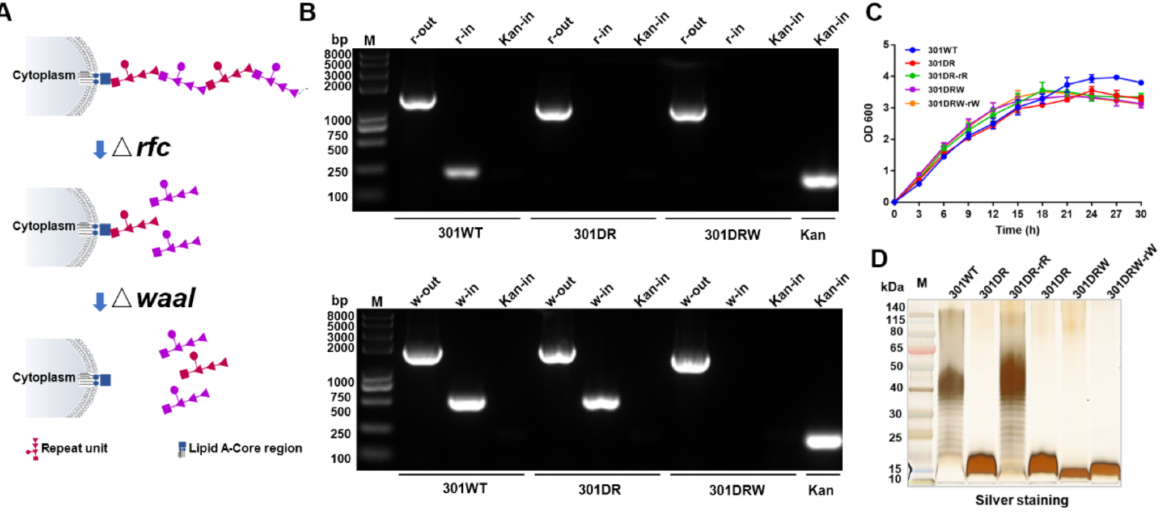
Figure 1. Establishment of rfc and waaI deletion mutants. ( A ) Schematic diagram of the effect of gene knockout on polysaccharides. rfc is an O-antigen polymerase and the knocking out of rfc prevents RUs polymerization, resulting in only one RU in the lipid A-core. waaI is an O-antigen ligase. The further knocking out of waaI prevented the polymerized polysaccharide chain from connecting to the lipid A-core. ( B ) PCR analysis of mutants in the rfc and waaI genes. ( C ) Growth curve analysis of knockout mutant strains. 301DR-rR indicates a 301DR revertant strain (301DR containing pACY184-rfc), 301DRW-rW indicates a 301DRW revertant strain (301DRW containing pACY184-waaI). ( D ) Silver staining of LPS from various strains. The typical ladder could not be detected by silver staining after rfc deletion. 301DR-rR and 301DRW-rW indicated the LPS, extracted from 301DR-rR and 301DRW-rW revertant strains,